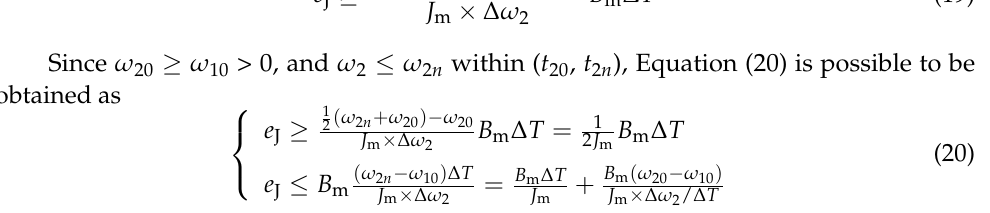
Table 1. Parameters of the motor.